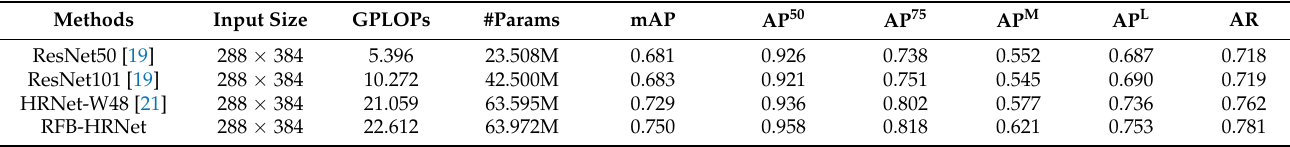
Table 3. Comparison on the AP10K validation